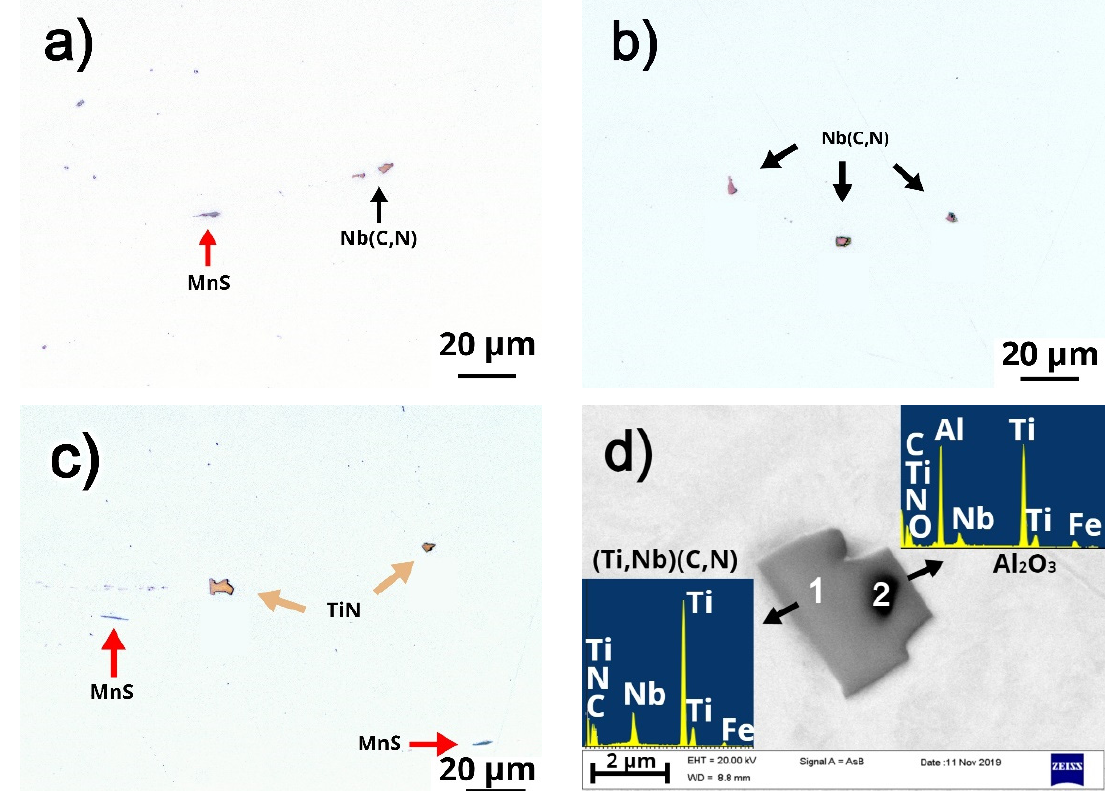
Figure 4. Non-metallic inclusions in steel Nb, V–Nb, and Ti–Nb in hot-rolled conditions. ( a ) Steel Nb, polished state, light microscopy; ( b ) steel V–Nb, polished state, light microscopy; ( c ) steel Ti-Nb, polished state, light microscopy; ( d ) steel Ti–Nb, FE-SEM BSE image with EDS analysis of the inclusion. Dark grey non-metallic inclusions in Figure 4a,c (marked by red arrows) represent MnS, which are deformable and oriented in the rolling direction. Black arrows represent primary Nb(C,N) inclusions. They are formed during solidification, because of the solute enrichment, meaning that real solidification follows non-equilibrium solidification with limited diffusion in solid. Primary and therefore coarse Nb(C,N) do not contribute